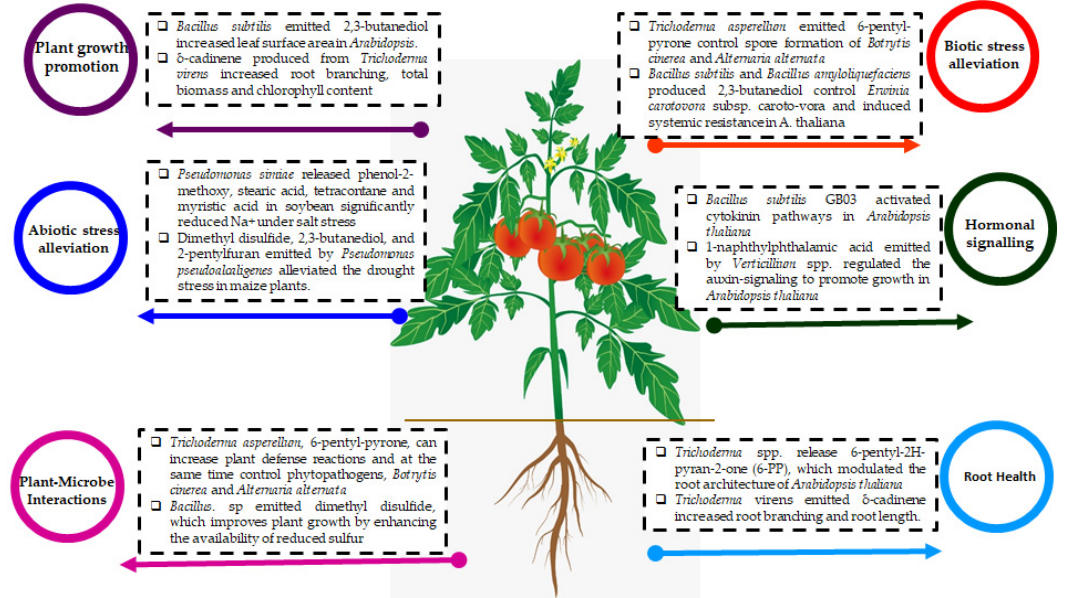
Figure 1. Microbial volatile organic compounds and their importance to sustainable agriculture development .